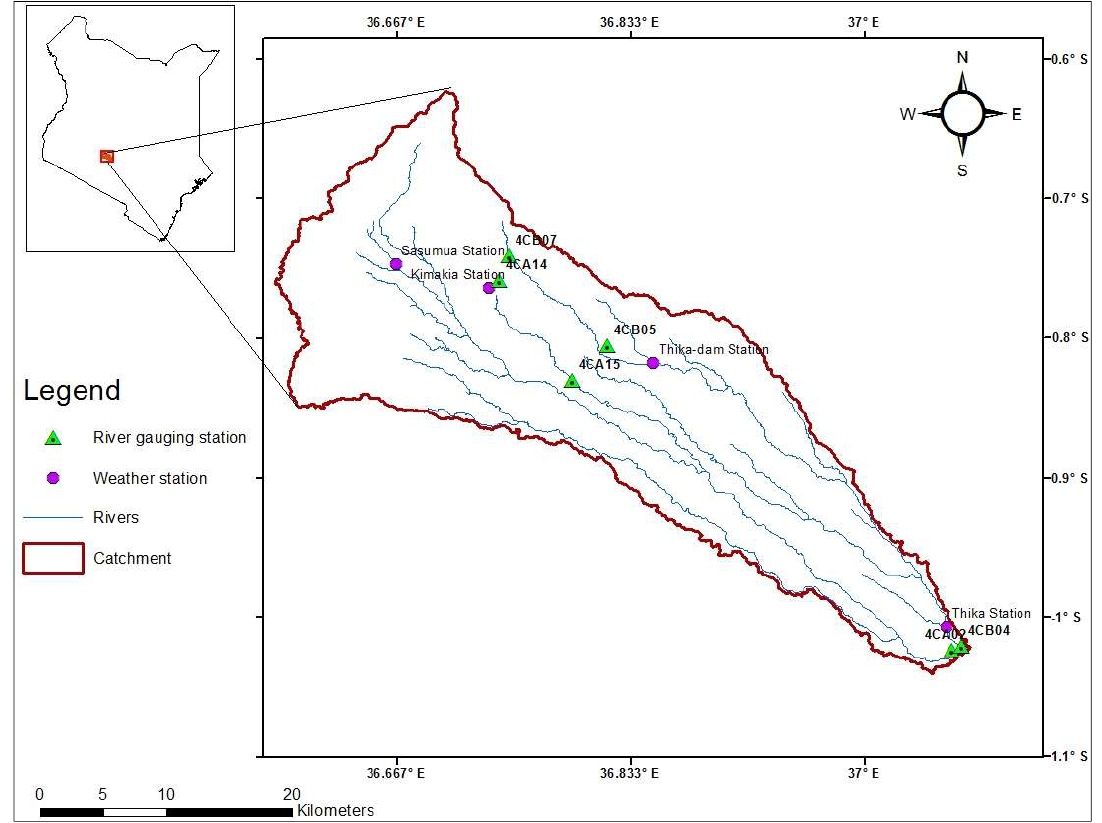
Figure 1. Thika-Chania catchment area.